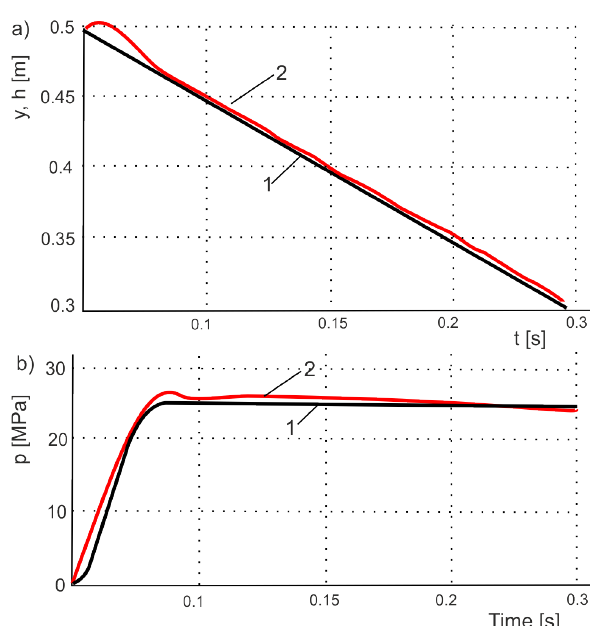
Figure 13: Trajectories of the reference parameters y ref ( t ) and p ref ( t )